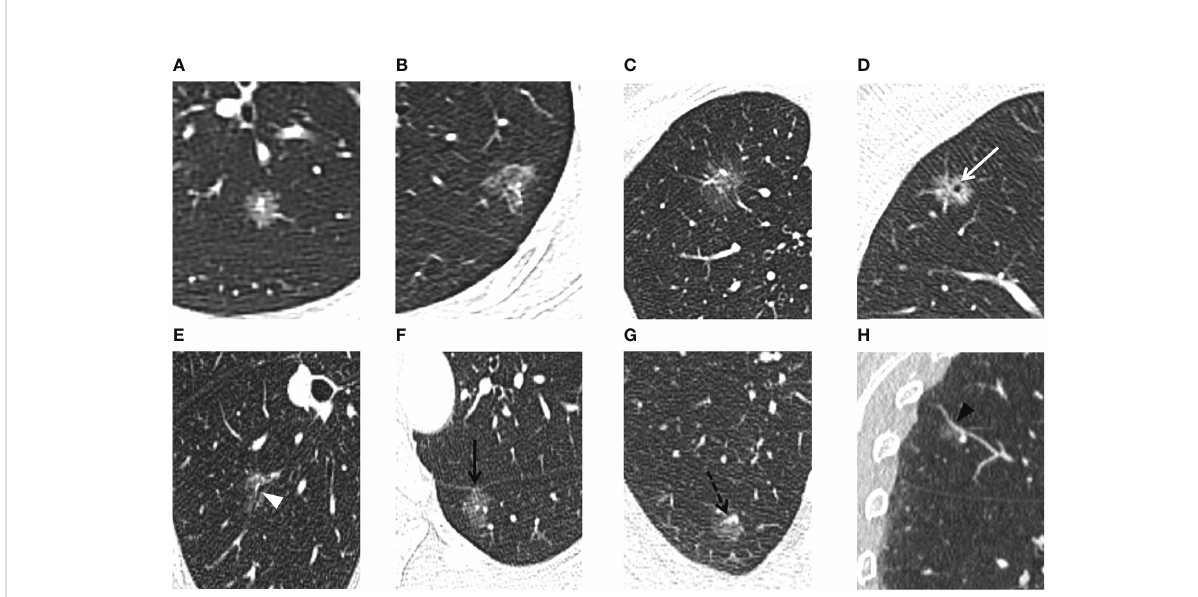
FIGURE 2 For the PSNs included in our study, thin-section CT radiographic features were evaluated. The lesion shape is evaluated as (A) round/oval or (B) irregular. The lesion border is evaluated as (A, B) de fi ned and (C) unde fi ned. (D) Vacuole sign: MIA in the right upper lobe exhibits a bubble-like lucency within the nodule (white arrow). (E) Air bronchogram sign: MIA in the right lower lobe shows air- fi lled bronchi present inside the lesion (white arrowhead). (F) Pleural indentation: MIA in the left lower lobe shows pleural indentation adjacent to the oblique fi ssure (black arrow). (G, H) Microvascular sign: IAC in the right upper lobe shows a small adjacent pulmonary vessel entering the lesion (black dotted arrow). Reverse tracing shows that the blood vessel is a branch of the pulmonary artery. Coronal reconstruction better shows the dilation of the supplying vessel (black arrowhead).